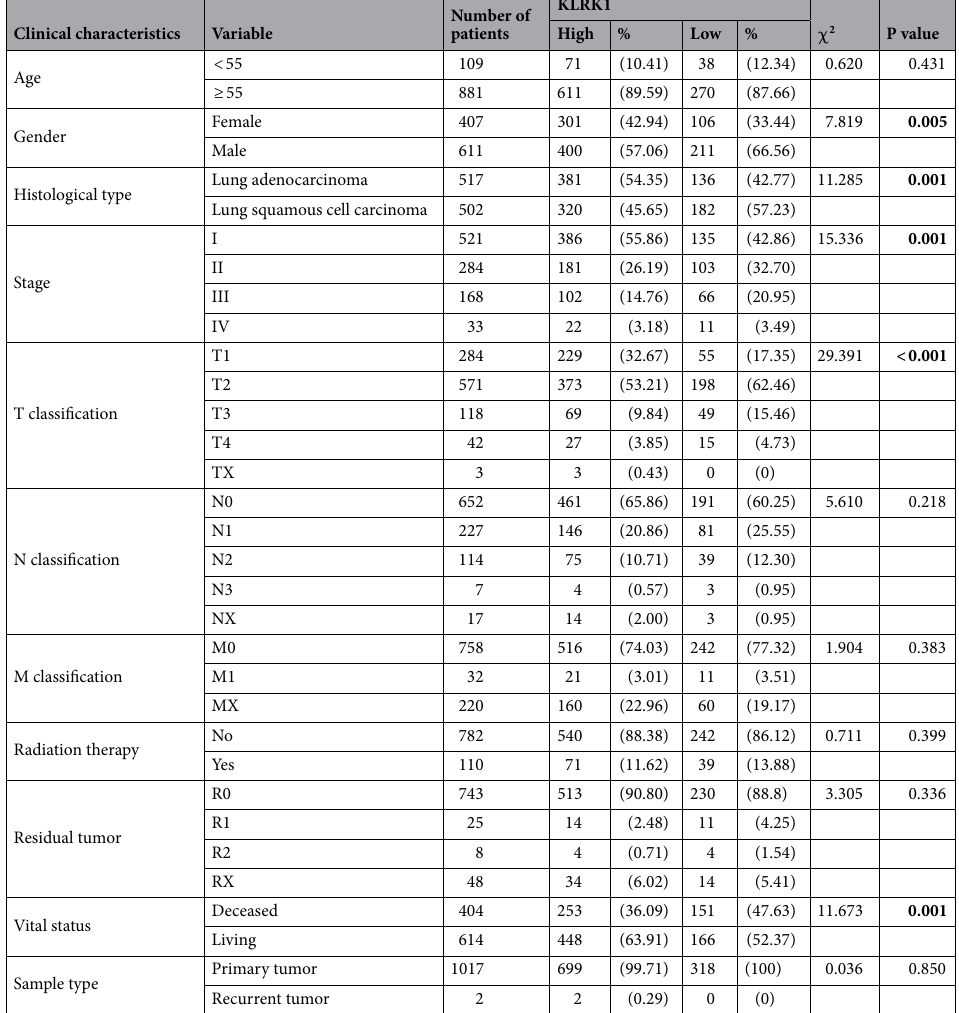
Table 2. Relationship between the clinical features and KLRK1 expression in patients with lung cancer. X represents